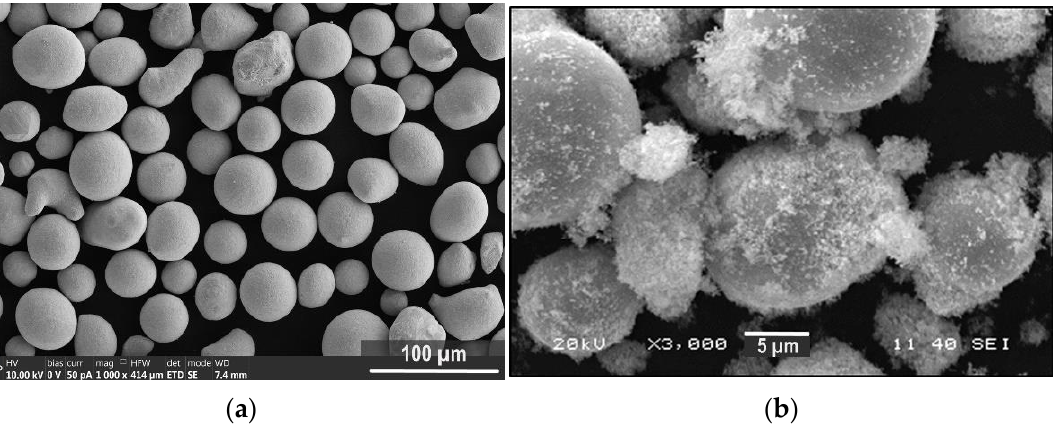
Figure 4. SEM images of W-5Ni-2Fe micropowder after plasma processing ( a ), area of micropowder with nanoparticles presence ( b ).